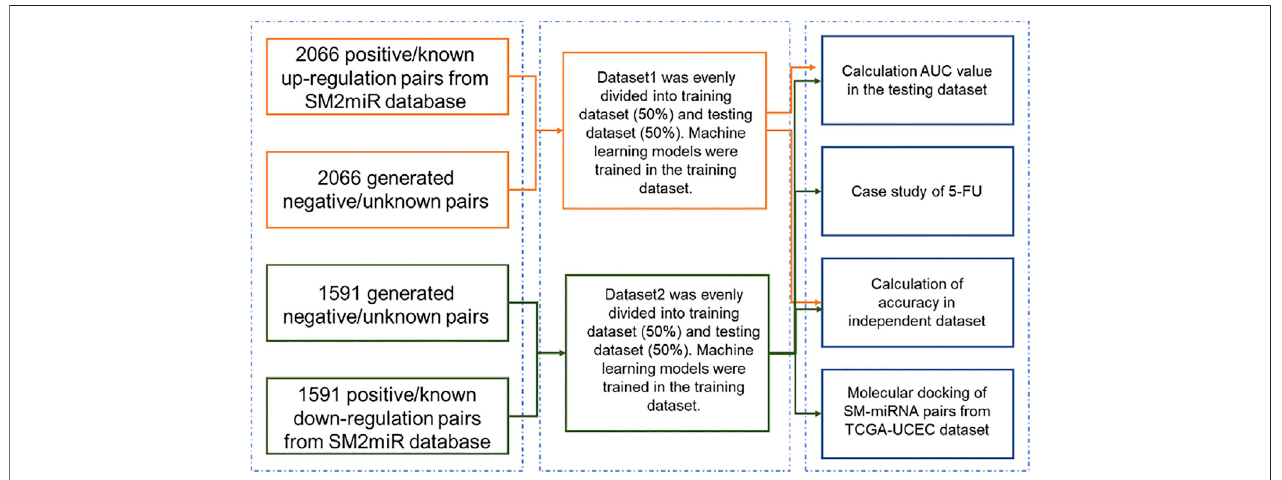
FIGURE 1 | Flowchart of developing models for SM-miRNA regulation prediction.